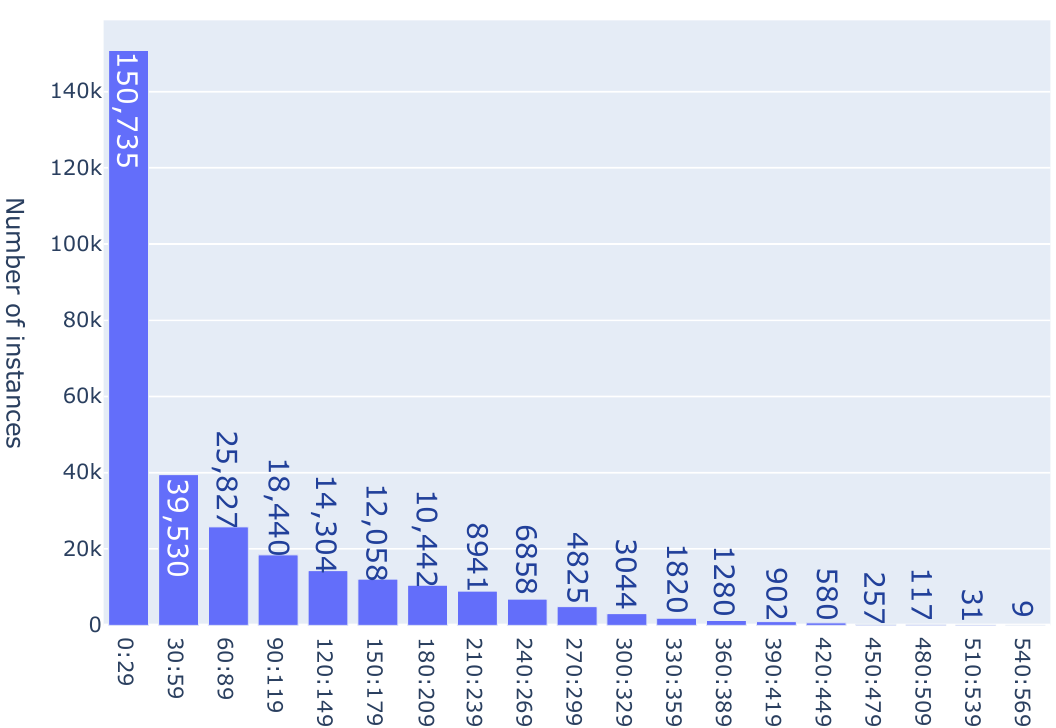
Figure 3. Number of branching points for the instances with 6